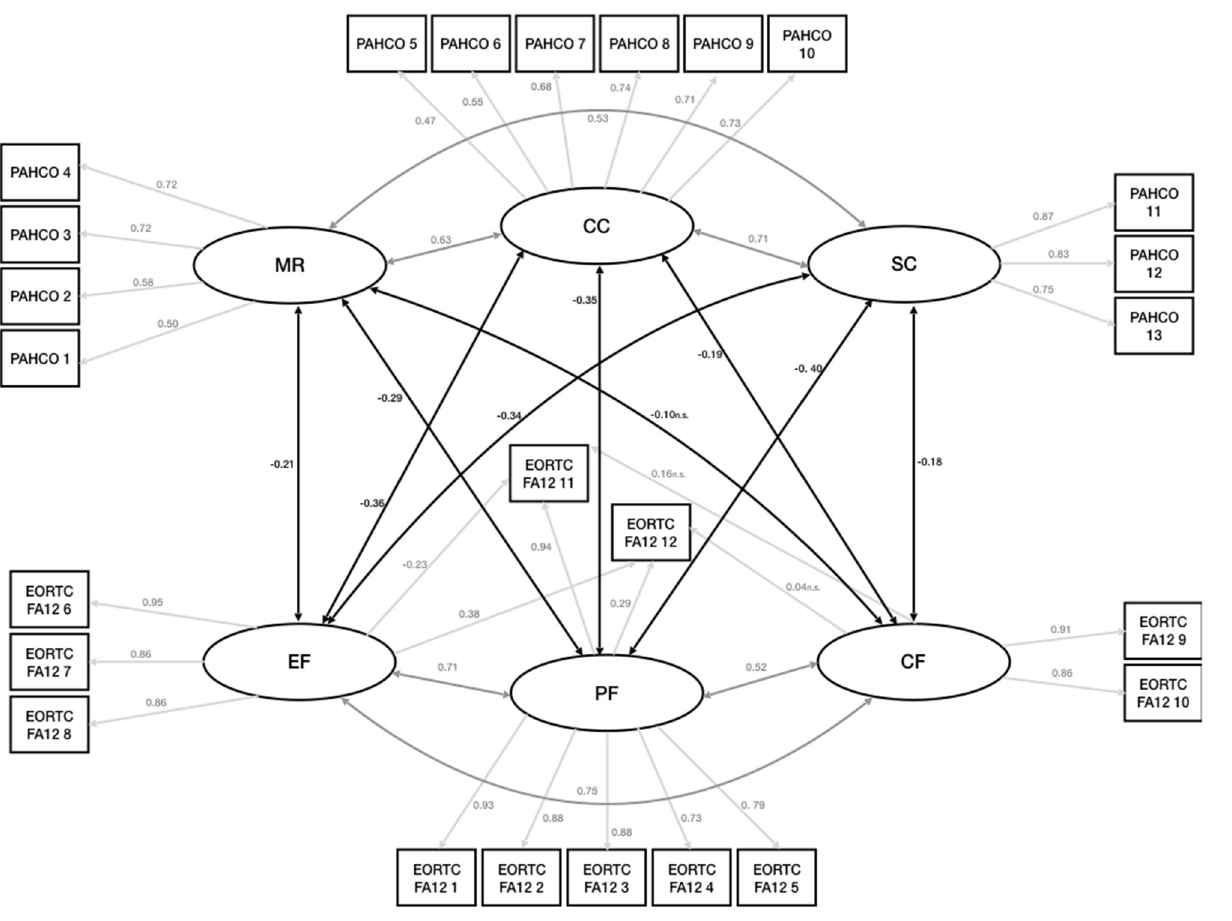
FIGURE 3 | Measurement model and structural components. EORTC FA12, EORTC QLQ-FA12; PF, Physical Cancer Related Fatigue; EF, Emotional Cancer Related Fatigue; CF, Cognitive Cancer Related Fatigue; PAHCO, Physical Activity Related Health Competence; MR, Physical Activity Specific Mood Regulation; CC, Control Competence for Physical Training; SC, Physical Activity Specific Self